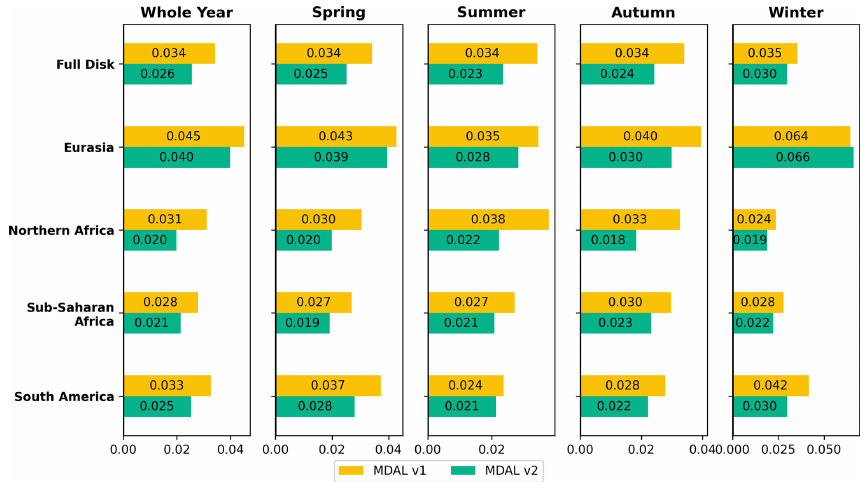
Figure 10. Mean MAE with respect to ETAL by region and season (season names referring to season months of the Northern Hemisphere; spring: MAM; summer: JJA; autumn: SON; winter: DJF).